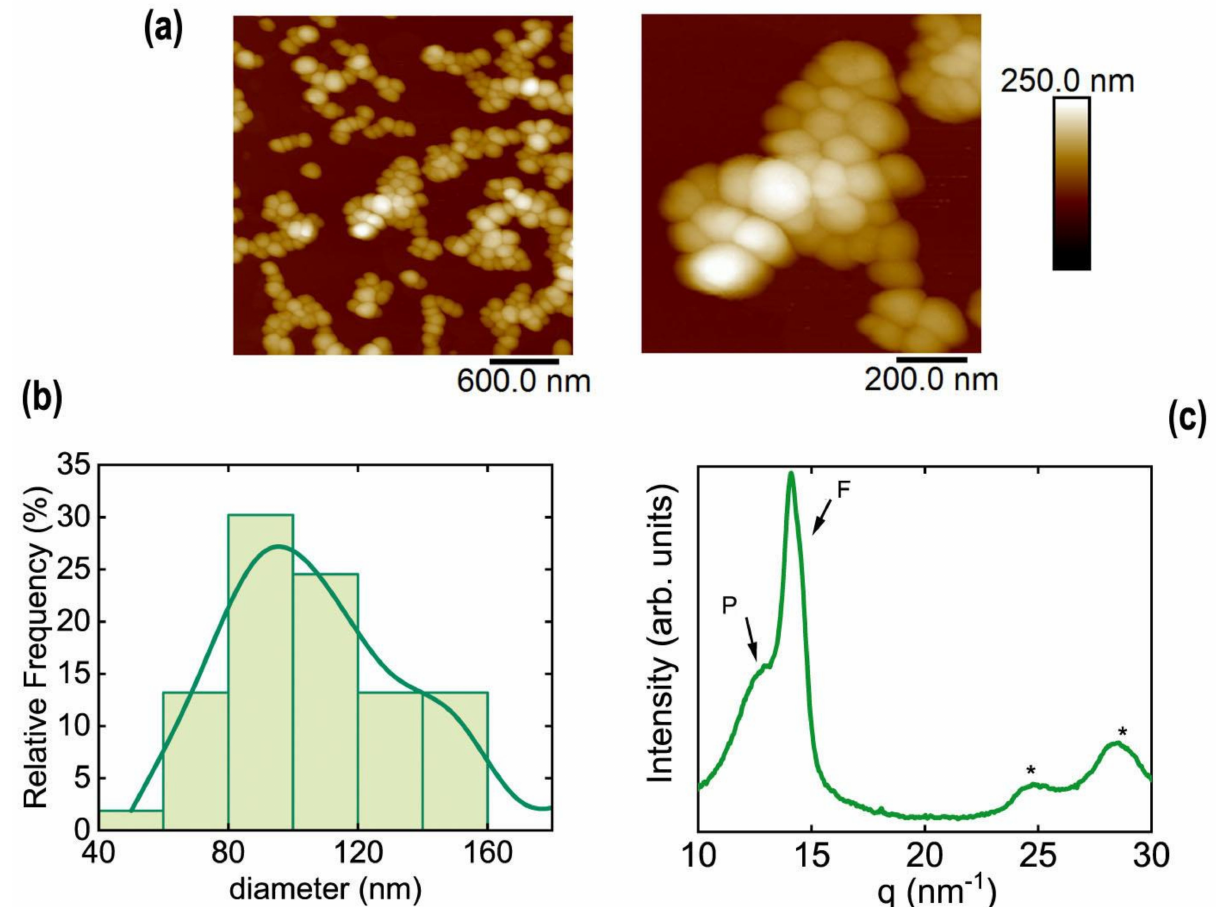
Figure 7. ( a ) Examples of AFM topography images of P(VDF-TrFE) nanoparticles prepared by flash nanoprecipitation; ( b ) histogram for the measured diameters of P(VDF-TrFE) nanoparticles prepared by flash; ( c ) diffractogram obtained from P(VDF-TrFE) nanoparticles prepared by flash and deposited by drop-casting. Most intense peaks associated with paraelectric (P) and ferroelectric (F) phase are labelled. Peaks marked with an * are associated to the ferroelectric